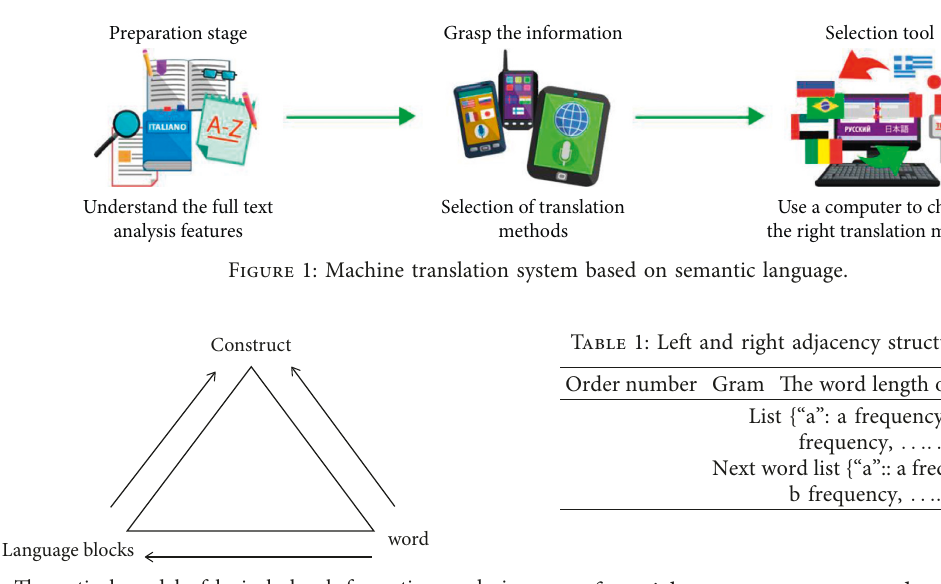
Figure 2: Theoretical model of lexical chunk formation analysis “construction (chunk (word)).”